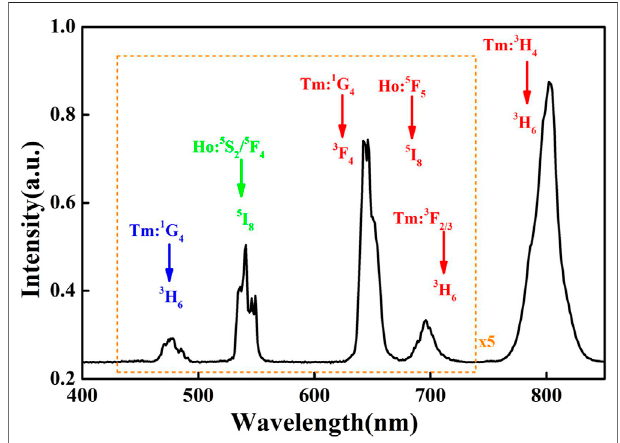
FIGURE2| Up-conversionspectraofthesampleunder theexcitation of 980-nm laser (the emission intensities of 475, 540, 650, and 692 nm was magni fi ed fi ve times).